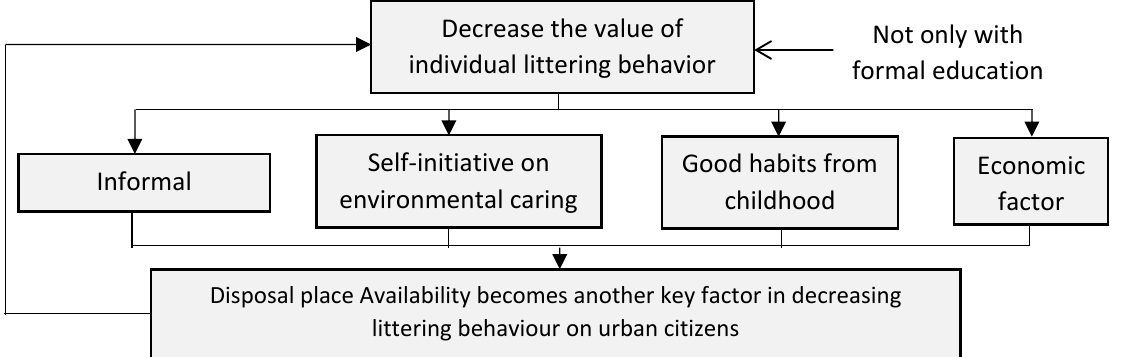
Fig. 1: Framework concept to decrease the value of individual littering behaviour